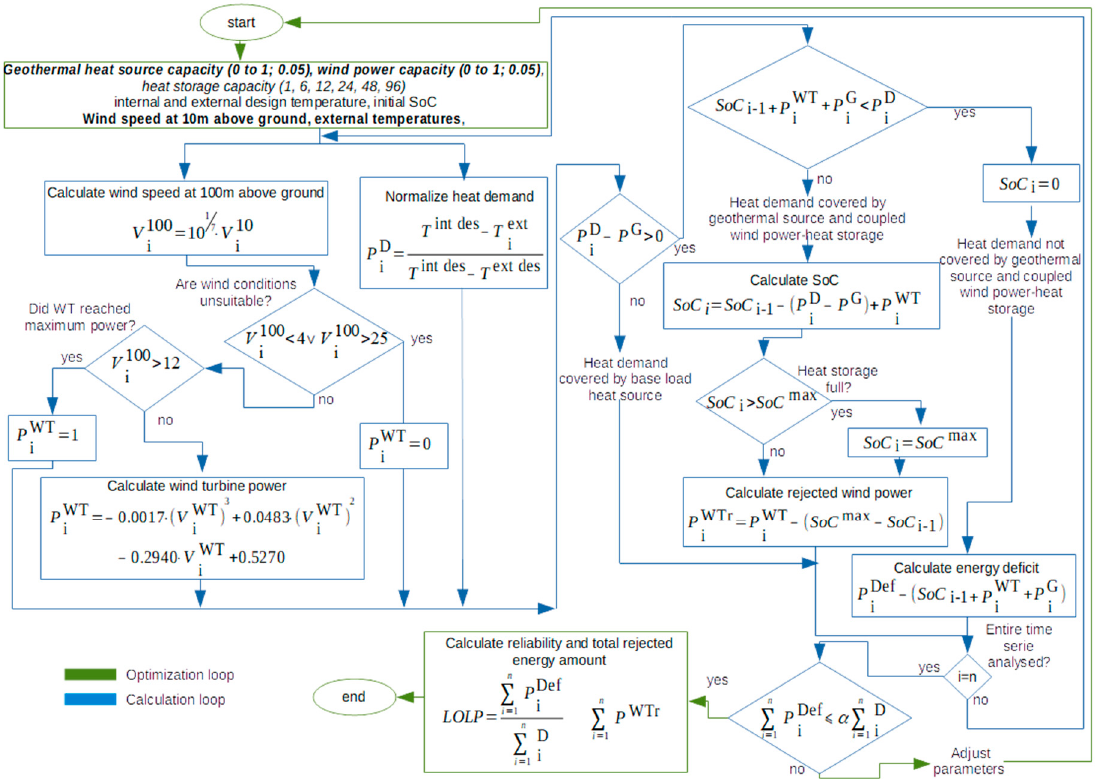
Figure 1. The procedure of calculation performed during the modelling process. The parameters that were changed in consecutive optimisation loops are in bold italic font , constant parameters are in italic font , presumptions and descriptions are given in normal font, whilst bolded are input data in time series. The parameters are given in brackets (value range; increment). The algorithm of the optimisation loop is elaborated in Appendix B. Symbols, superscripts and subscripts are explained in Abbreviations.